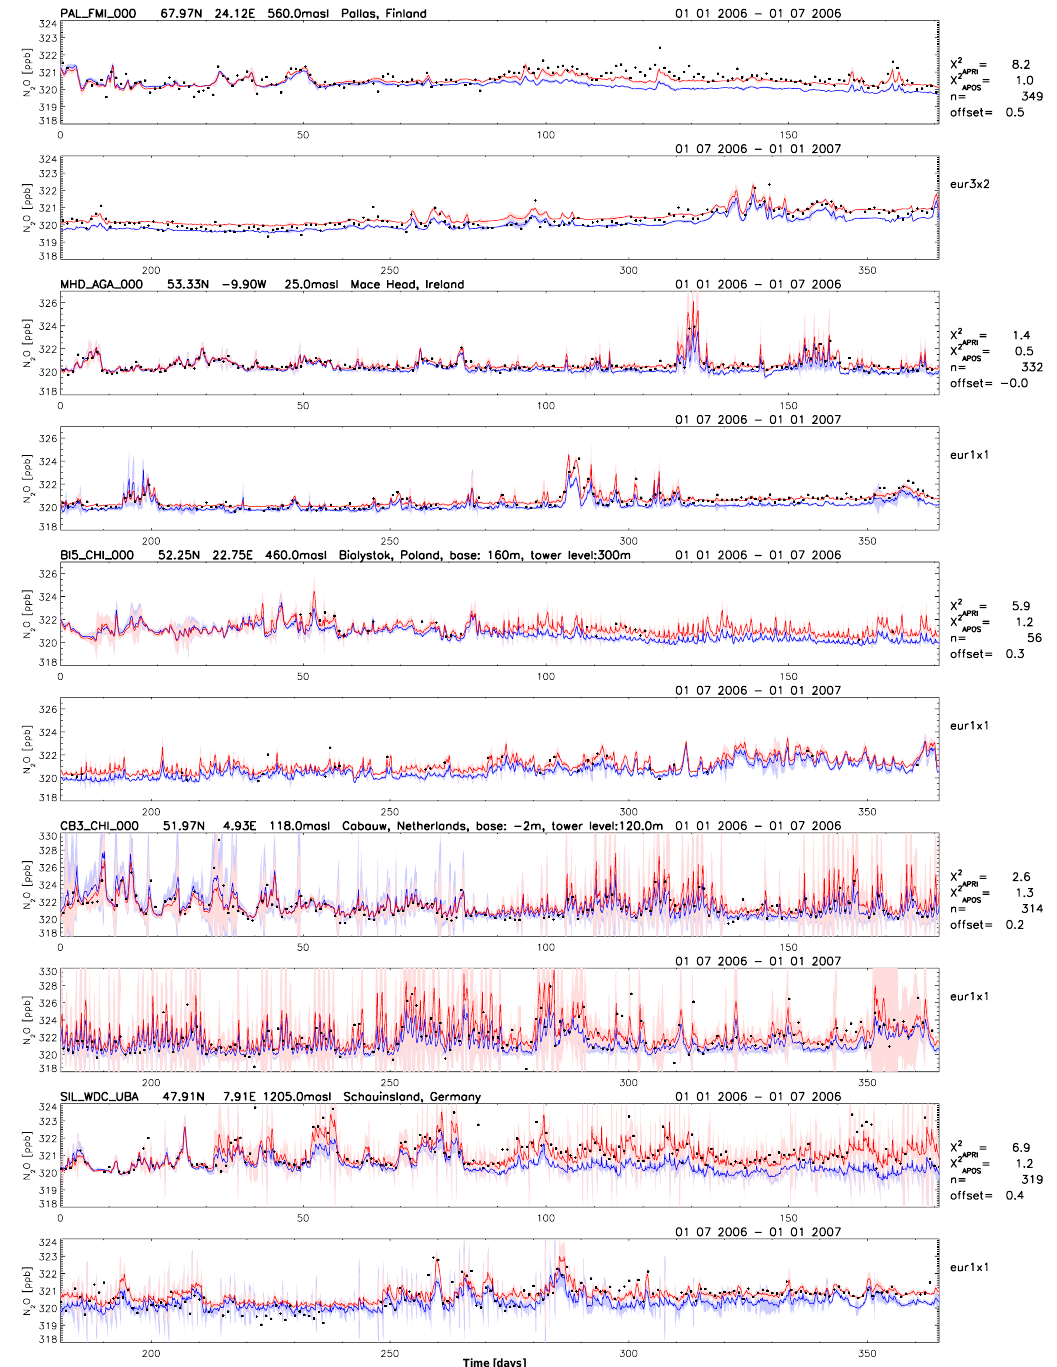
Fig. 2. Time series (days) of observed and simulated N 2 O mixing ratios at 5 of the available European stations: Pallas, Mace Head, Bialystok, Cabauw, and Schauinsland. One year of data, from 1 January to 31 December 2006, is split into two 6-month panels for each station. Blue lines represent a priori simulations and red lines are a posteriori simulations for the reference inversion S1. Shaded areas represent estimated uncertainties of the model simulations. Measurements are shown as black dots. The calculated bias corrections (offset) are given on the right of each panel and have been subtracted from the measurements. Units are